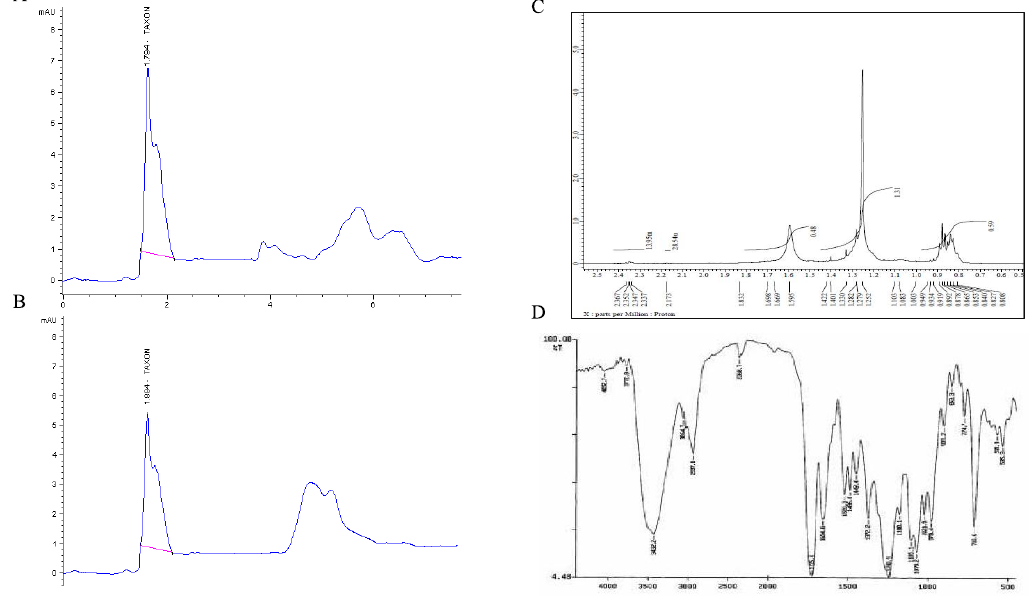
Fig. 2. Chromatographic and Spectral analyses of the extracted Taxol from A. terreus. HPLC chromatogram of authentic Taxol. (A), A. terreus extracted Taxol (B). NMR spectrum (C) and FT-IR spectrum (D) of A. terreus